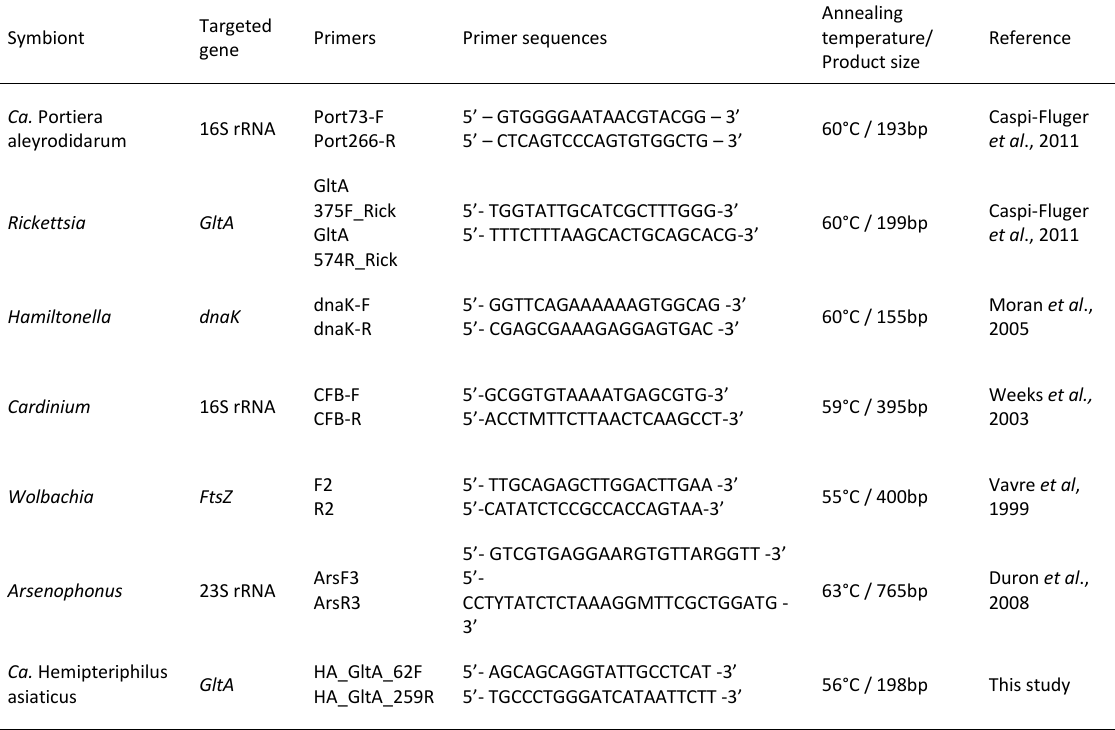
Table 3. PCR primers and conditions used for symbionts’ screening